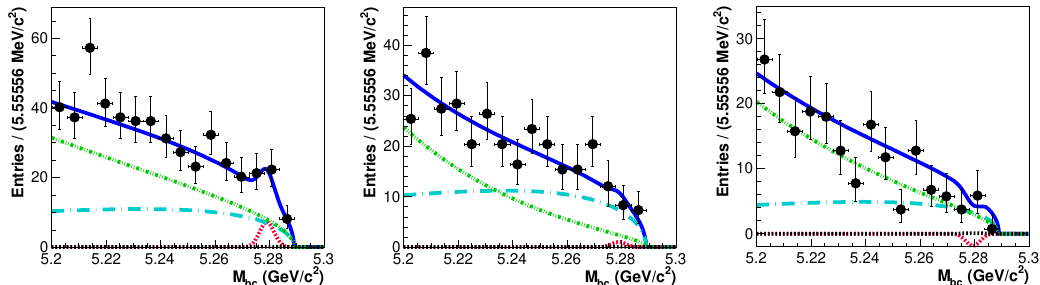
Figure 7 . Signal-enhanced M projection of three-dimensional unbinned extended maximum- bc likelihood fits to the data events that pass the selection criteria for decays B + → K + µ + e − (left), B + → K + µ − e + (middle), and B 0 → K 0 µ ± e ∓ (right). The legends are same as in figure S